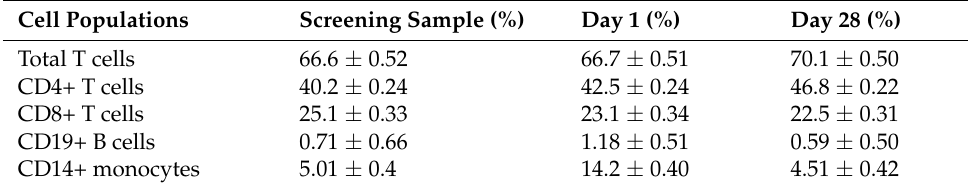
Table 2. Impact of PCLX-001 treatment on T cells, B cells, and monocyte population. Cell